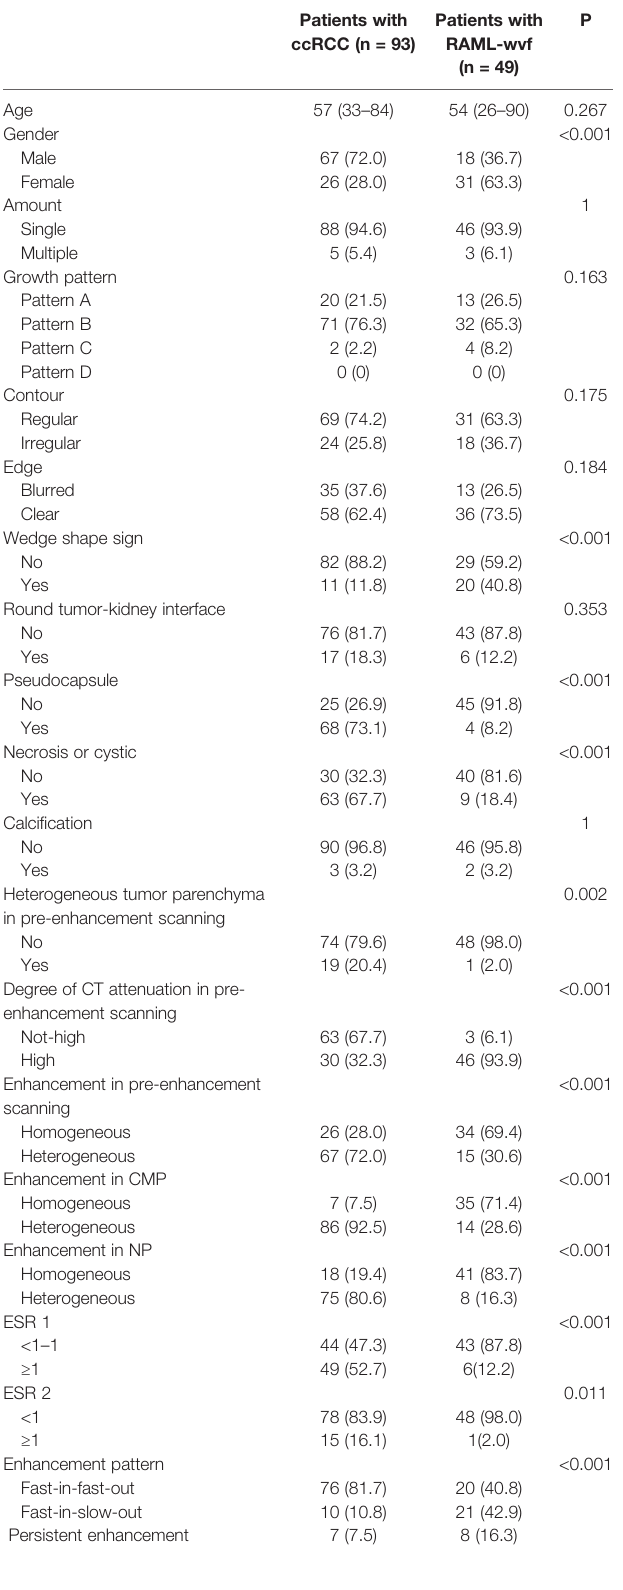
TABLE 1 | Comparison of Characteristics Between Patients with ccRCC and RAML-wvf.